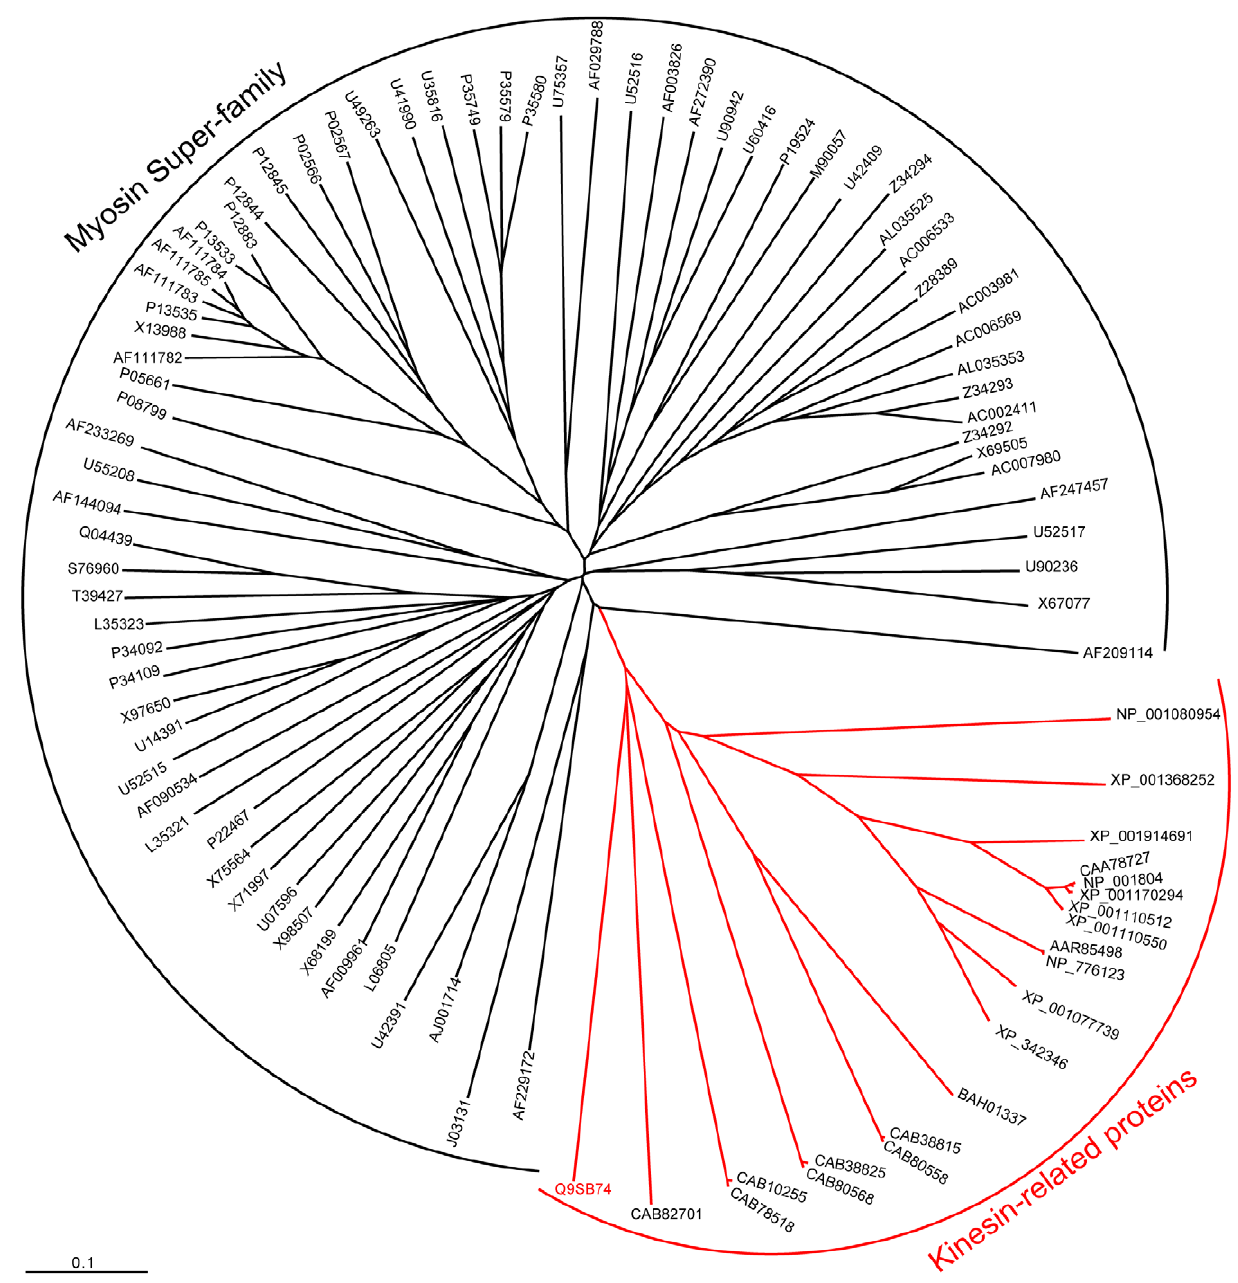
Figure 8. Unrooted Phylogenetic tree. Representative members of the myosin superfamily [53] and kinesin-like proteins were aligned with A. thaliana AtAUCSIA-1IP (i.e Q9SB74, written in red) and a phylogenetic tree was built exploiting the Clustal W algorithm [103]. The protein sequences used in the phylogenetic analysis are listed as follows. For myosin super-family: Homo sapiens (AF009961, X68199, X98507, X71997, U14391, X97650, AF111785, AF111784, X13988, AF111783, P13533, P12883, P13535, P35579, P35580, P35749, AF111782, AF229172, U90942, U60416, AF272390, U90236, U55208, AJ001714, U42391, AF247457, AF144094, AF209114), Drosophila melanogaster (U07596, P05661, U35816, J03131, AF003826, X67077, AF233269), Caenorhabditis elegans (X75564, U52515, P12844, P02566, P12845, P02567, U41990, U49263, U52516, U52517), Saccharomyces cerevisiae (S76960, Q04439, P19524, M90057), Schizosaccharomyces pombe (T39427, U75357, AF029788), Dictyostelium discoideum (P22467, P34092, L35323, P34109, L06805, AF090534, P08799, L35321, U42409), Arabidopsis thaliana (X69505, Z34292, AC007980, Z28389, Z34293, Z34294, AL035525, AC006569, AL035353, AC002411, AC006533, AC003981). For kinesin-related proteins: H. sapiens (CAA78727, NP_001804), Xenopus laevis (NP_001080954), Mus musculus (NP_776123, AAR85498), Equus caballus (XP_001914691), Monodelphis domestica (XP_001368252), Pan troglodytes (XP_001170294), Rattus norvegicus (XP_001077739, XP_342346), Macaca mulatta (XP_001110550, XP_001110512), Arabidopsis thaliana (CAB78518, CAB10255, CAB82701, CAB80568, CAB80558, CAB38825, CAB38815), Oryza sativa (BAH01337). Bar represents 0.1 point mutation per sequence position.